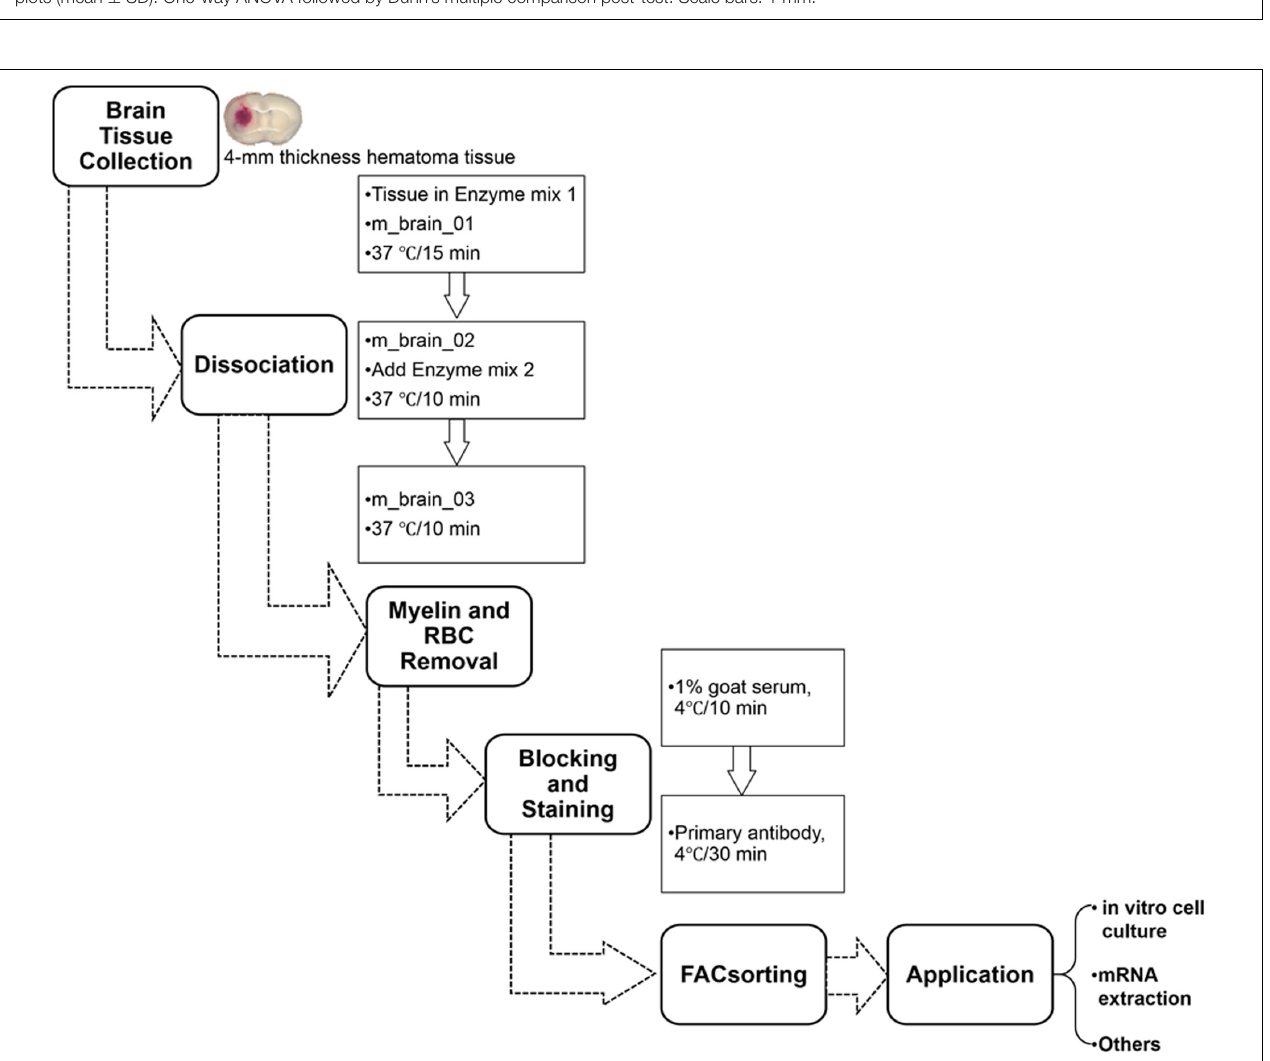
FIGURE 2 | Procedure for isolating mouse microglia and monocyte-derived macrophages after ICH. RBC, red blood cells.